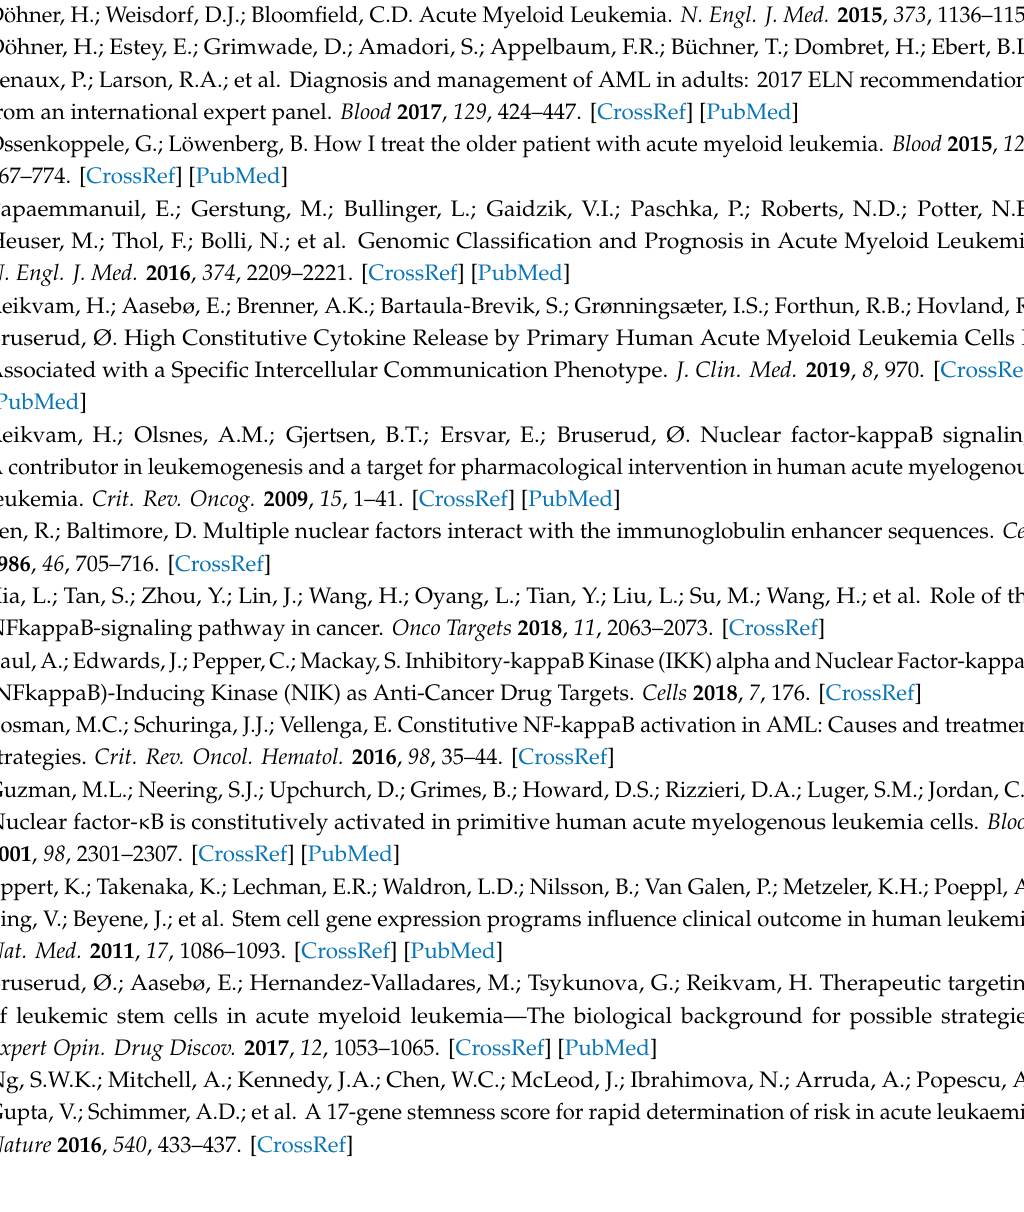
Table S1. Gene di ff erently expressed by NF- κ B inhibition in primary AML cells. Table S2. Protein interaction networks modulated by NF- κ B inhibition in human AML; a summary of the four interaction networks showing decreased mRNA expression in primary human AML in response to NF- κ B inhibition. Table S3. Protein interaction networks modulated by NF- κ B inhibition in human AML; a summary of interacting genes with showing increased mRNA expression in primary human AML in response to NF- κ B inhibition. Figure S1. Network analysis of genes with upregulated expression after NF- κ B